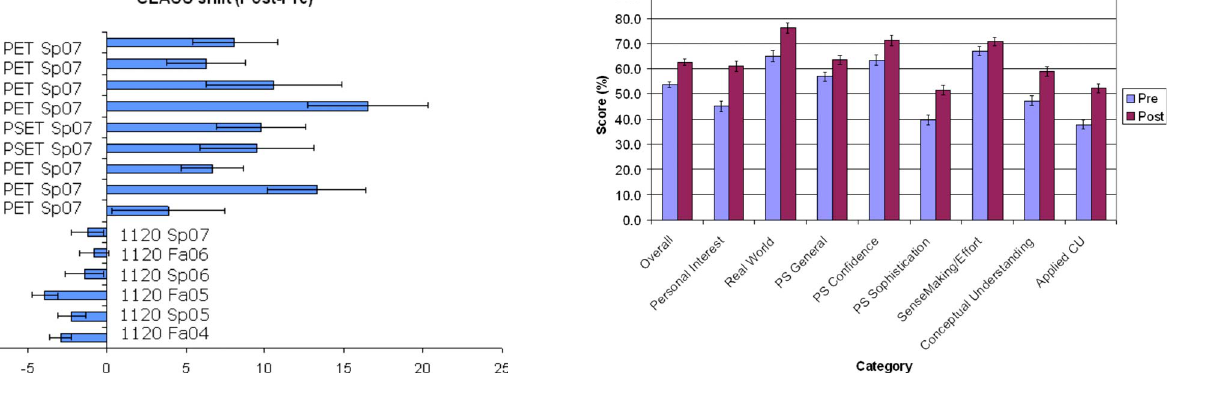
FIG. 2. (cid:1) Color (cid:2) CLASS shifts for PET and PSET courses com- pared to calculus-based courses; PET and PSET courses are num- bered to match corresponding data in Table III.